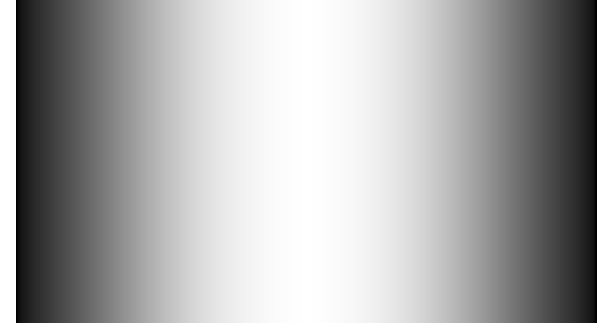
Figure 6. A conceptual representation of the gradient mask